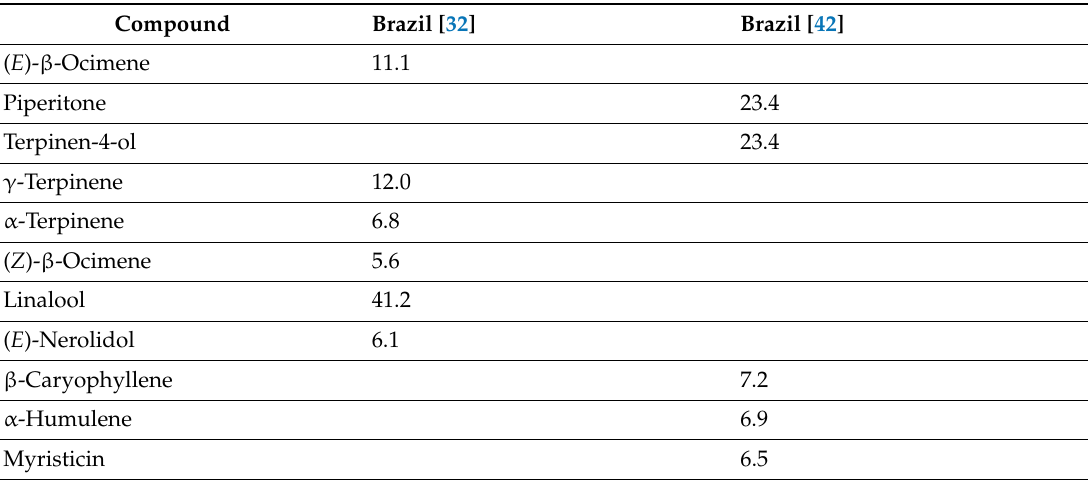
Table 5. Chemical compositions (%) of Piper aduncum floral essential oils.